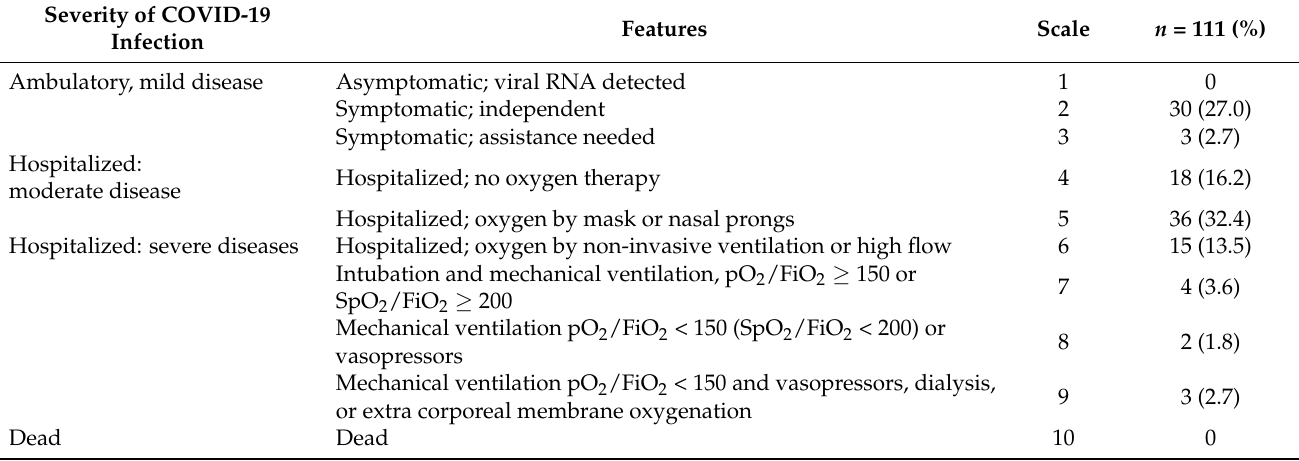
Table 2. Severity of COVID-19 infection in our population based on the World Health Organization clinical progression